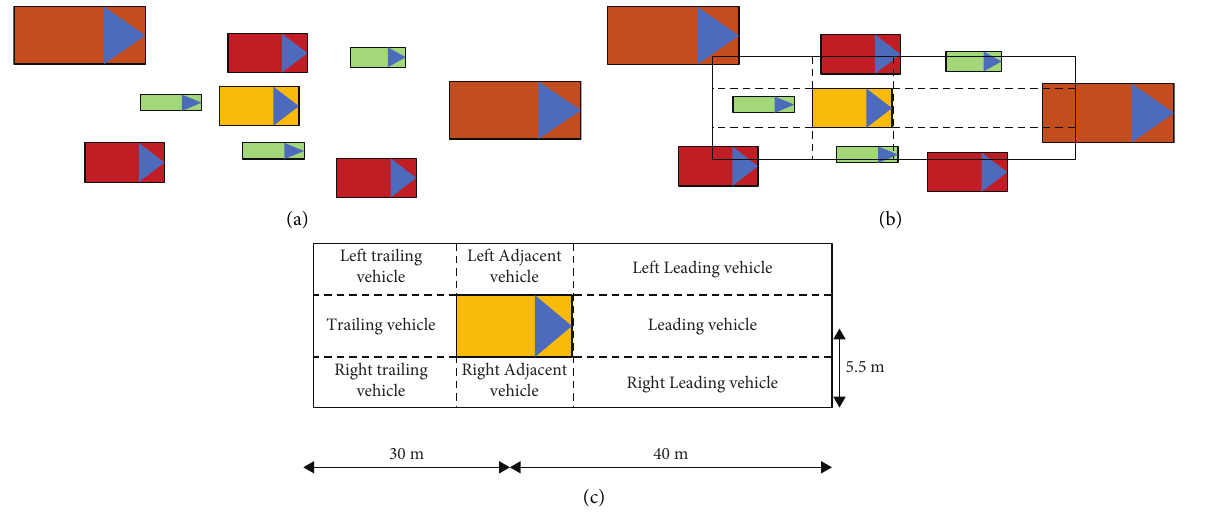
Figure 3: Explaining the surrounding vehicle combination for the subject